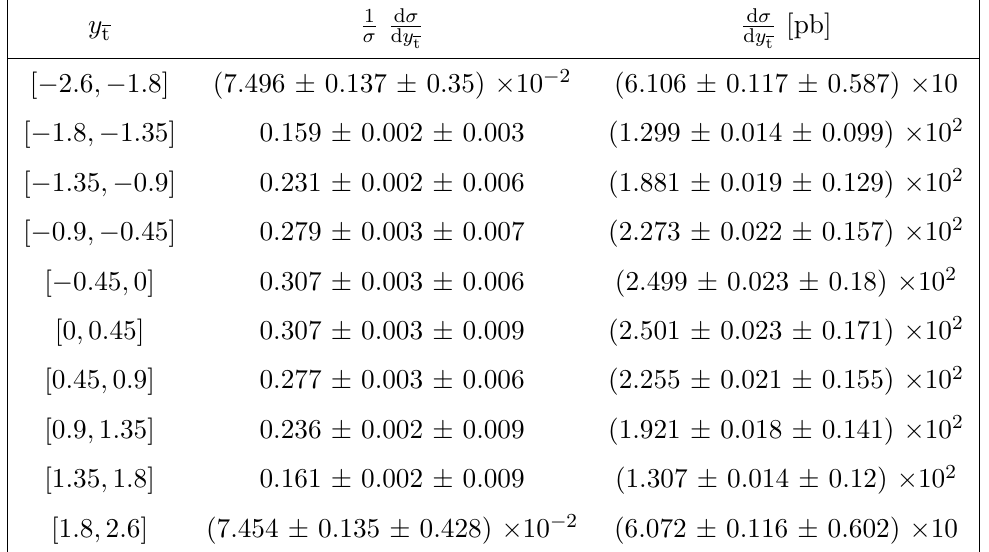
Table 7 . The measured di(cid:11)erential cross section and bin boundaries for each bin of the normalized and absolute measurements of the tt di(cid:11)erential cross section at parton level in the full phase space as a function of y are tabulated. t